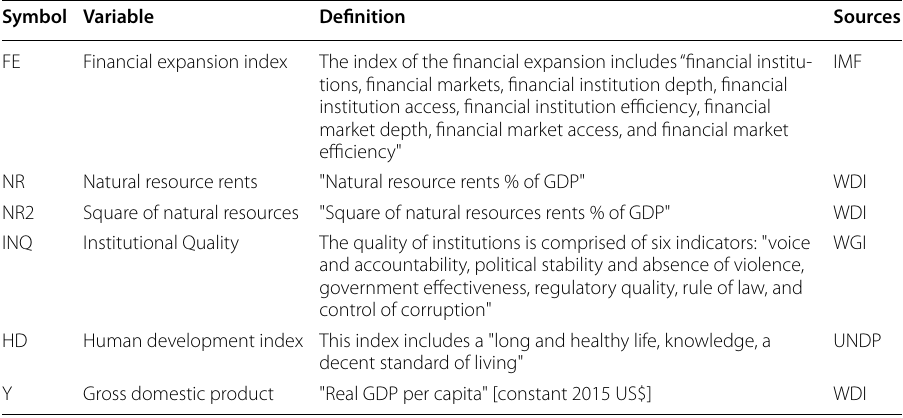
"WDI refers to World Development Indicators, WGI stands for World Governance Indicators, IMF stands for International Monetary Fund, and UNDP stands for United Nations Development Programme"